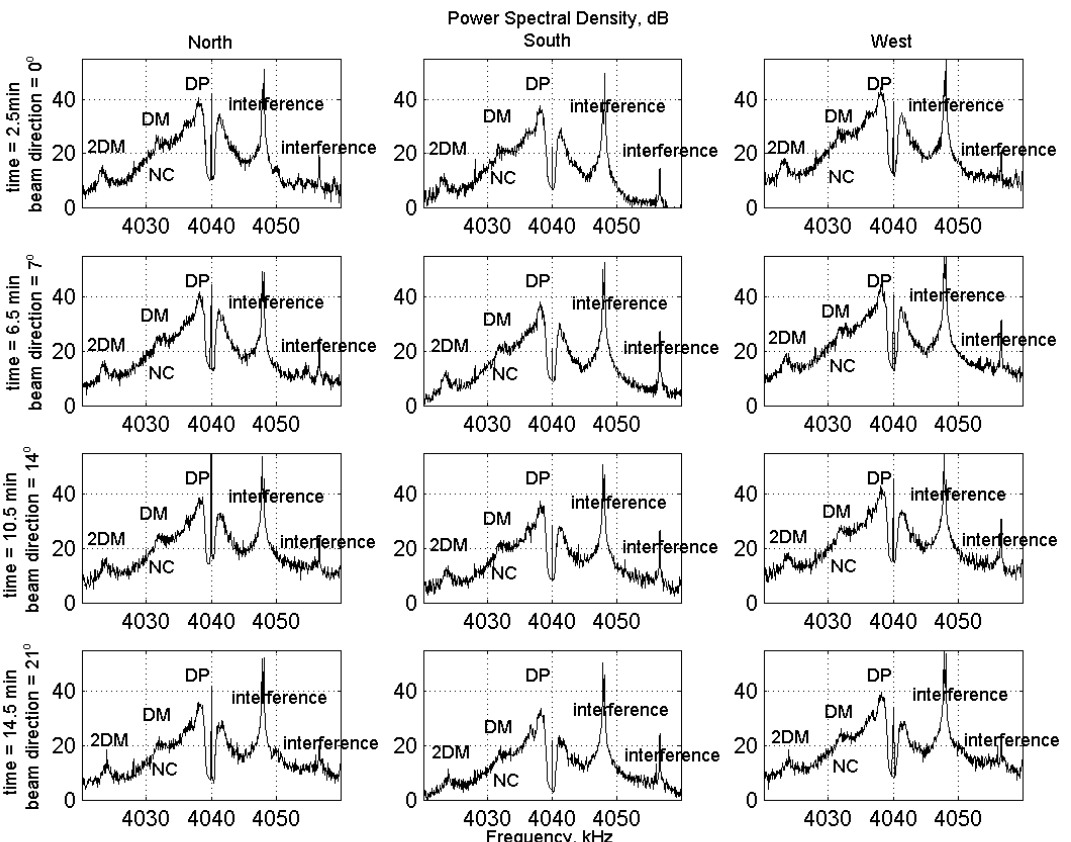
Fig. 5. SEE power spectral densities for the north (left column), south (central column), and west (right column) antennas at four different times and pump antenna beam directions. Both the DP component and the narrow continuum (NC) are clearly seen in the SEE spectra. The time at the left of each plot refers to minutes after 15:30 UT on 6 October 2004. The beam direction is degrees south of